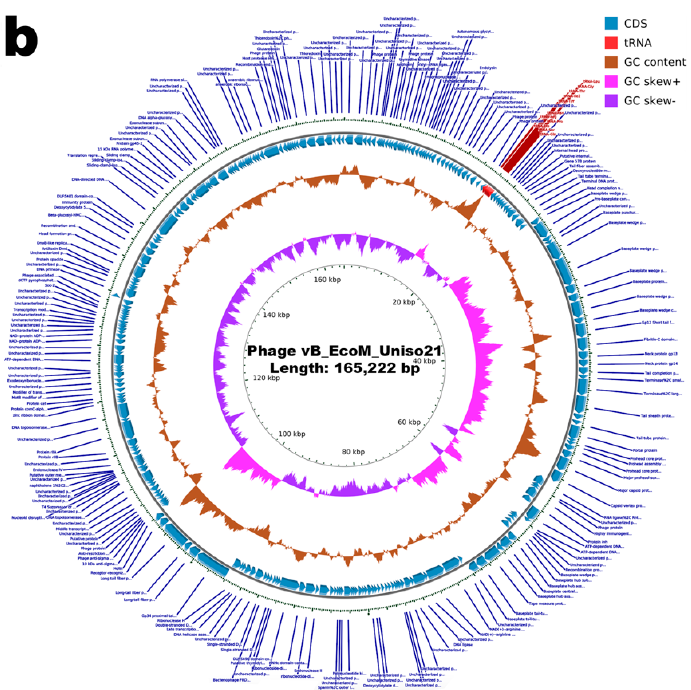
Figure 11. Annotated genome maps of phages ph0011 ( a ) and ph0021 ( b ). In these circular maps, predicted CDS, GC skew (+/ − ) and GC content are displayed. The innermost ring indicates the GC skew of phage genome (+, magenta; − , purple), the middle ring indicates GC content (brown) and, in the outer ring, the blue arrows represent the annotated coding sequences (CDSs) according to the annotation in Supplemental Table S1 and the red arrows represent tRNAs. The direction of the blue arrows represent the direction of transcription (strand + or − ).